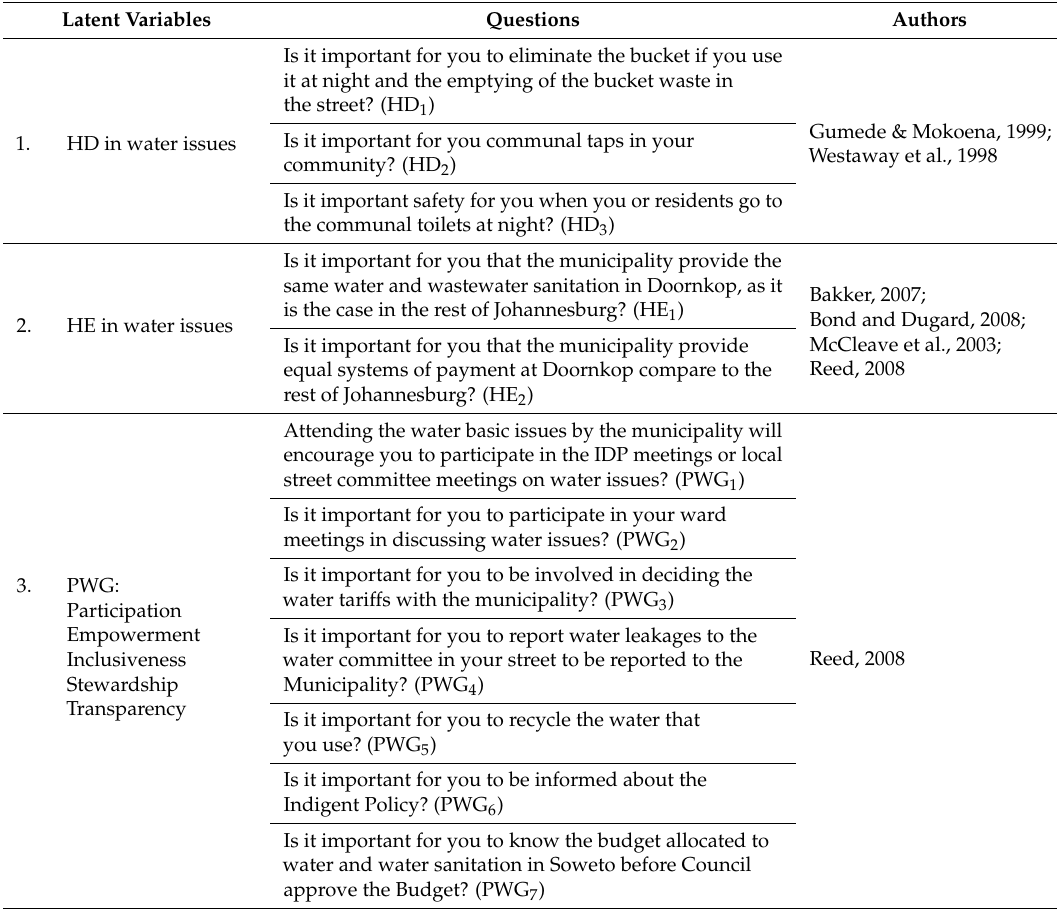
Table A1. Latent variables and elaborated